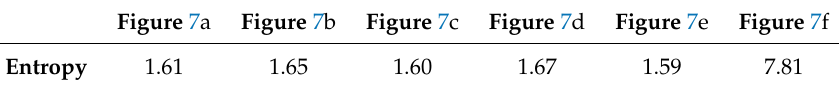
Table 3. Entropies of the imaging